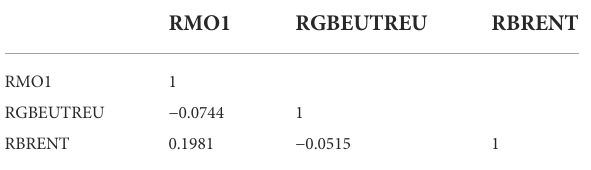
TABLE 3 Unconditional correlation of daily